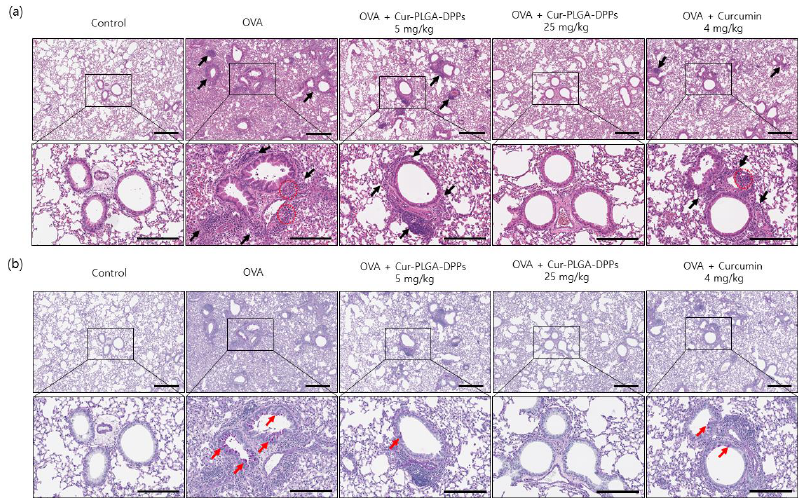
Figure 6. Histological analysis of the effects of Cur-PLGA-DPPs on OVA-induced asthmatic mice. ( a ) Representative results for the H&E staining of lung tissue. Black arrows indicate peribronchial dense inflammatory infiltration; red circles indicate prominent eosinophil infiltration. The scale bars represent 400 µm (upper panel) and 200 µm (lower panel). ( b ) Representative PAS staining of lung tissue. Red arrows indicate increased purple-colored PAS-positive mucin-containing goblet cells (goblet-cell hyperplasia). The scale bars represent 400 µm (upper panel) and 200 µm (lower panel). To investigate the anti-inflammatory effects of blank PLGA-DPPs, OVA-induced asthmatic mice were injected with 25 mg/kg blank PLGA-DPPs. H&E staining of lung sections showed massive infiltration of inflammatory cells in the peribronchial and perivascular areas (Figure 7). PAS staining indicated a considerable number of purple-colored mucin-positive goblet cells in the bronchial epithelium. These findings suggest that blank PLGA-DPPs had no anti-inflammatory effect on the lung tissue of asthmatic mice.